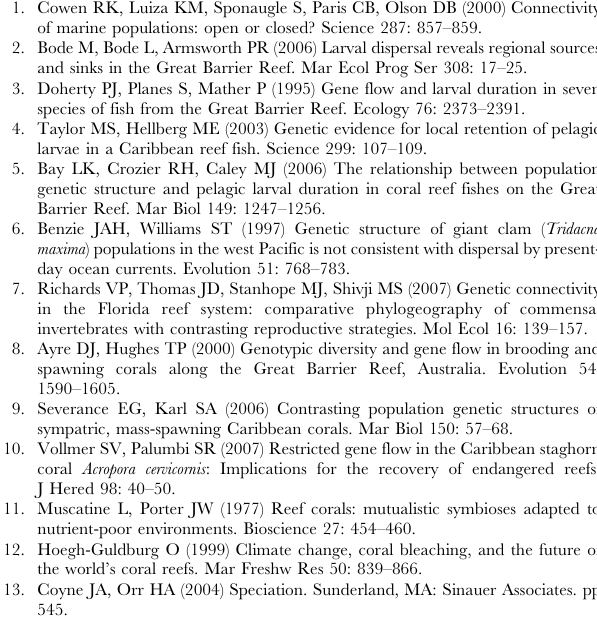
Table S1 Temporal patterns of Symbiodinium ITS2 ‘‘type(s)’’ and multilocus microsatellite genotype(s) from tagged M. faveolata colonies sampled between 2003 and 2005 in the Upper Florida Keys and Exuma Cays.